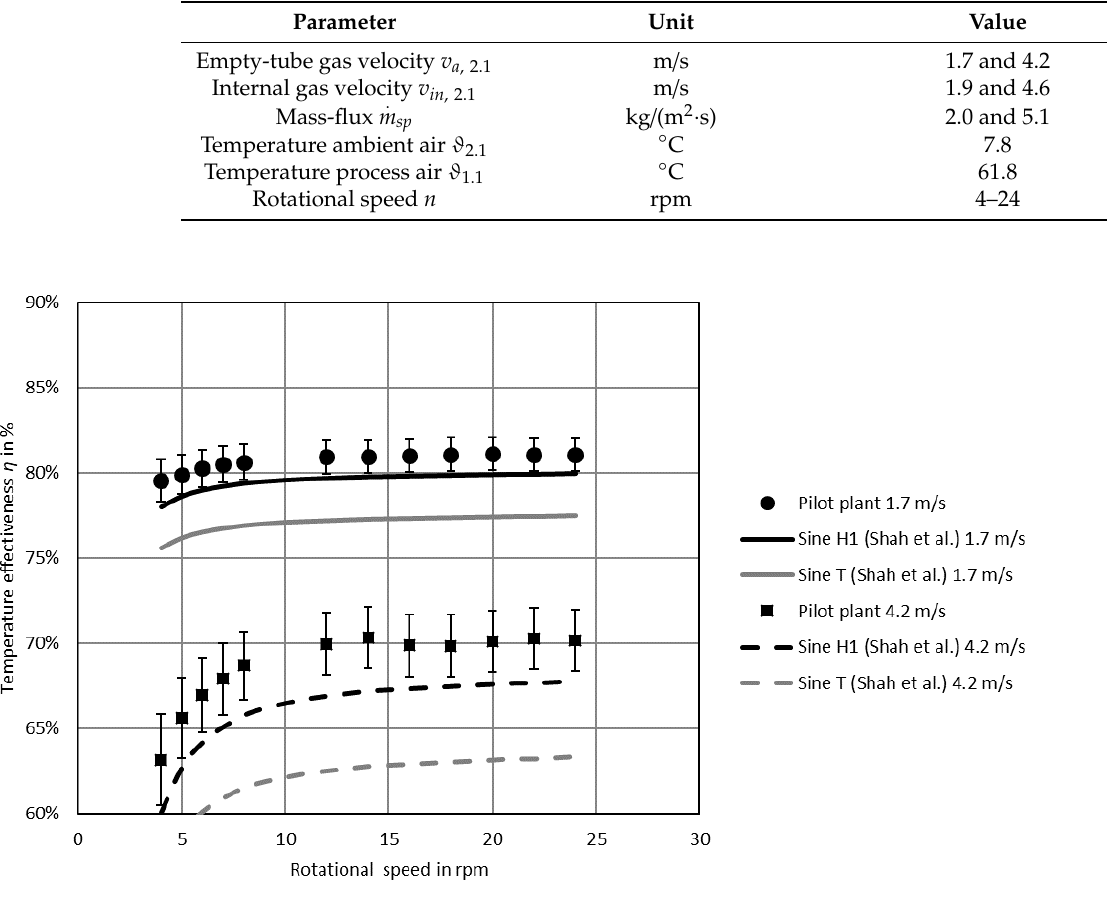
Figure 12. Results from pilot plant and simulation with predictions from the sine duct model from Shah and London.